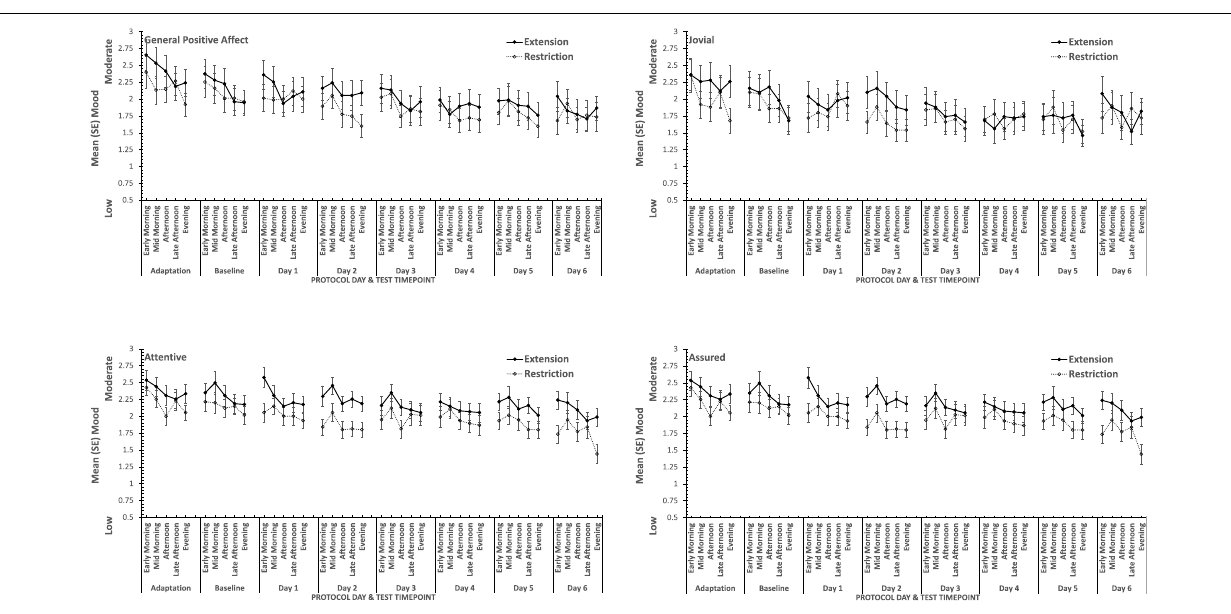
protocol, and then flattening. Negative moods, on the